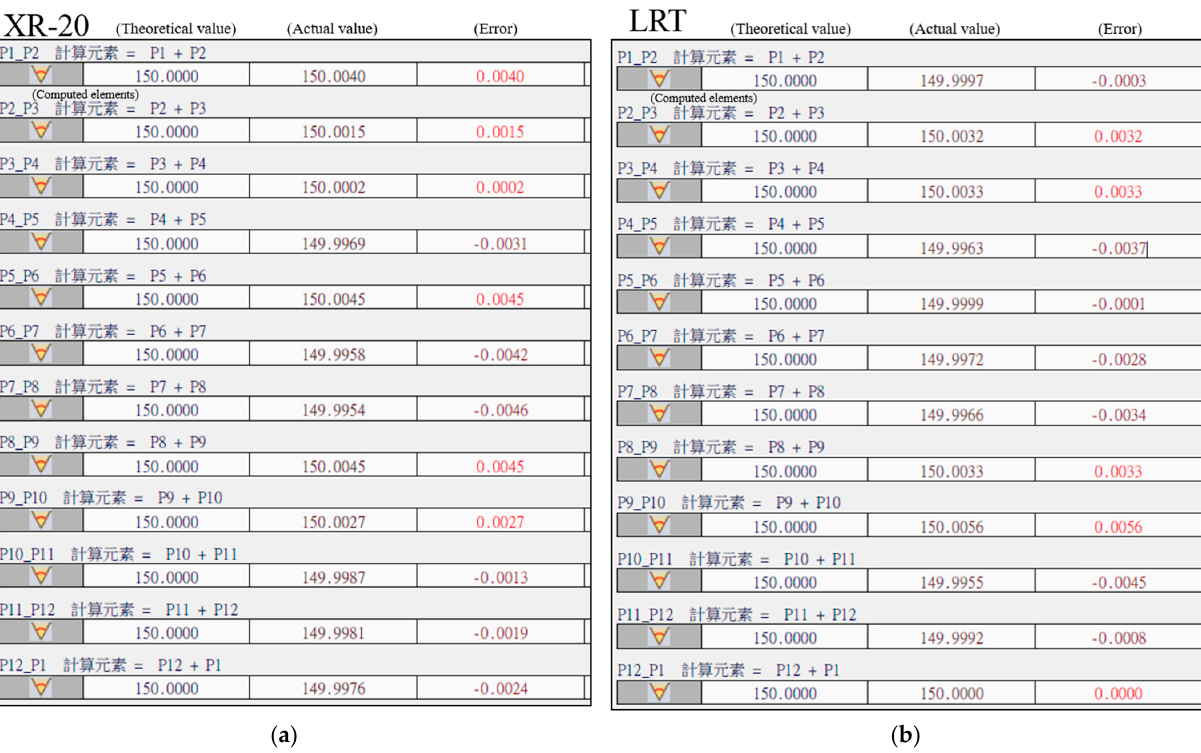
Figure 29. The measured result from CMM ABLE-686-CNC: ( a ) results from the workpiece using XR-20W; and( b ) results from the workpiece using Laser R-test.